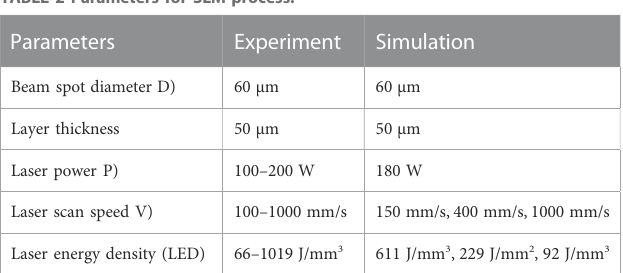
TABLE 2 Parameters for